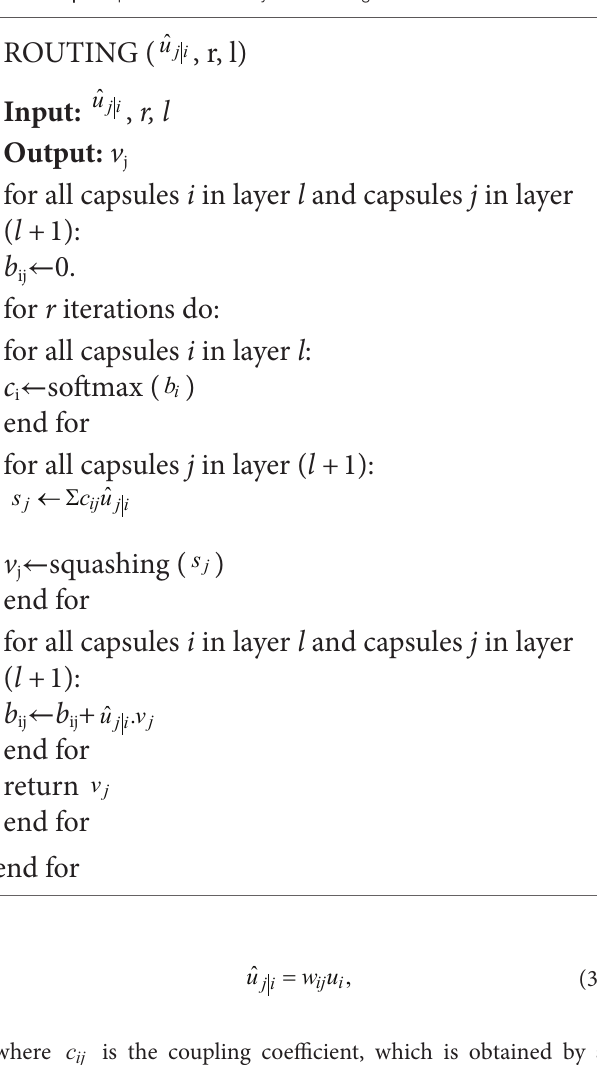
TABLE 2 | The pseudocode of a dynamic routing mechanism.